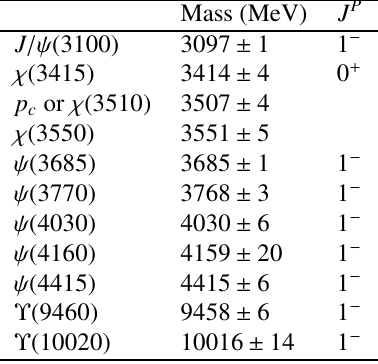
Table 1. States included in the Particle Data Group in 1980